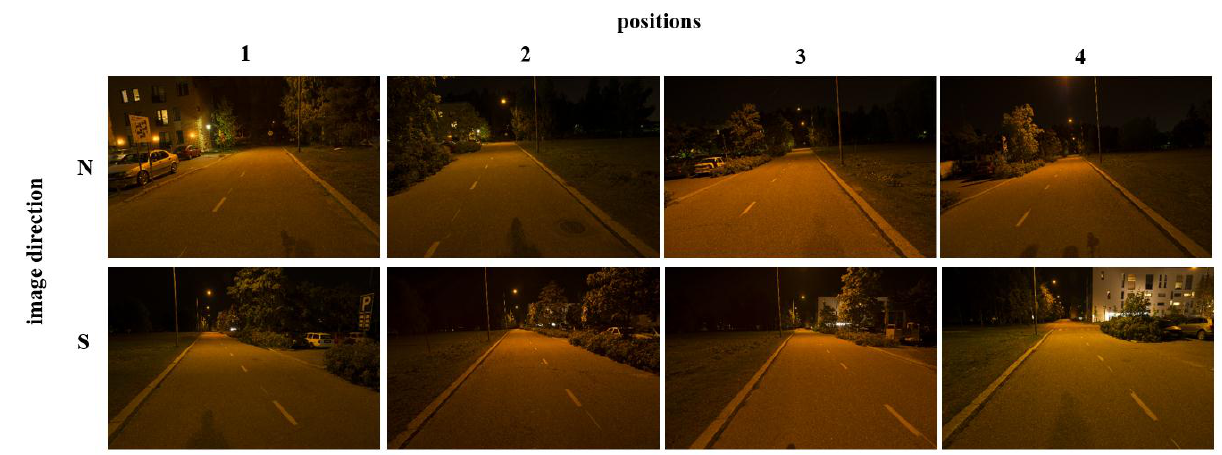
Figure 2. The image data included eight images covering a 150-metre long road section under night-time lighting conditions. The images were taken from four different positions and in both directions (north and